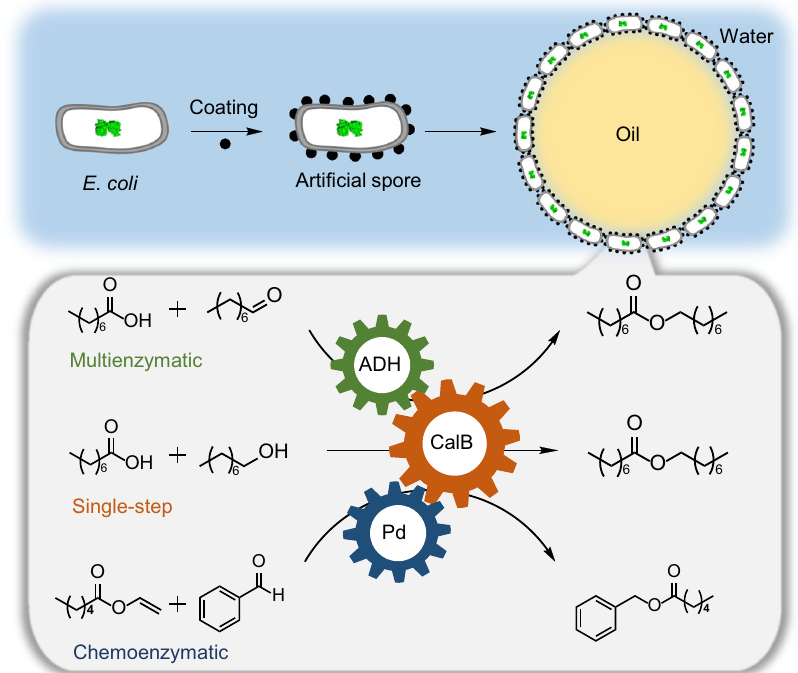
Fig. 1 Schematic of the coating on Escherichia coli ( E. coli ) cells as arti fi cial spores for interfacial biocatalysis. ADH alcohol dehydrogenase; CalB Candida antarctica lipase B; Pd palladium.